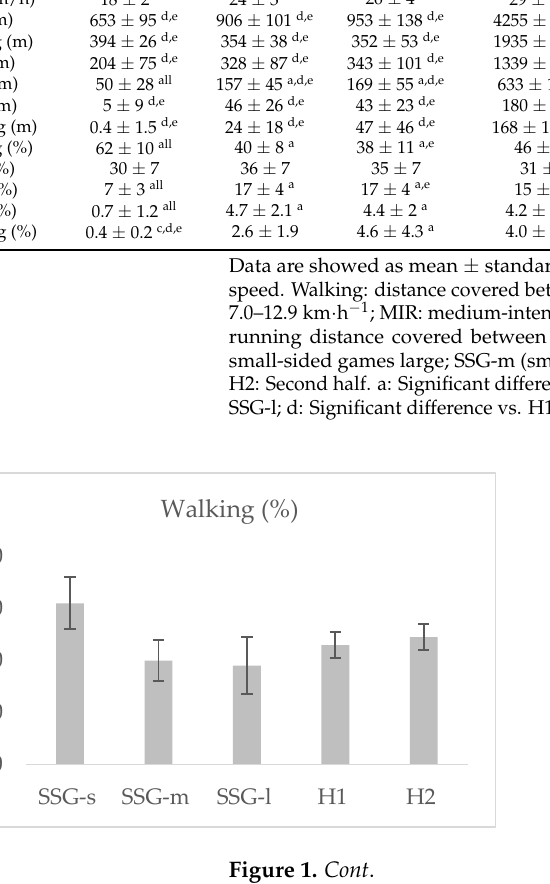
Figure 1. Distances covered to 5 ranges of speed in different SSG and competition match. Walking: distance covered between 0.1 – 6.9 km·h −1 ; Low-intensity running: distance covered between 7.0 – 12.9 km·h −1 ; Medium-intensity running: distance covered between 13 – 17.9 km·h −1 ; High-intensity running: distance covered between 18 – 20.9 km·h −1 ; Sprinting: distance covered >21 km·h −1 . SSG-l: small-sided games large; SSG-m (small-sided games medium), SSG-s (small-sided games small). H1: First half; H2: Second half. 4. Discussion The aims of this study were to assess the effect of different pitch size (SSG-s, SSG-m, and SSG-l) on the physical and physiological responses in young male soccer players, and to compare these metrics with those obtained during official games. The initial hy- pothesis was to consider that the SSG-l with similar characteristics and rules as the competition could present similar external and internal load in comparison with the of- ficial matches. The results of the present study showed different movement patterns within the different pitch size formats. The results obtained in these SSGs can be trans-